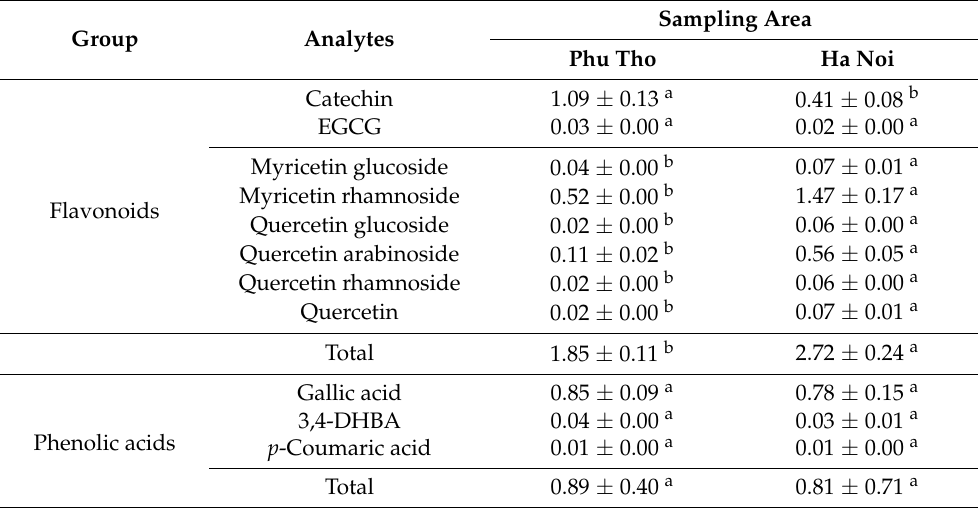
Table 3. Phenolic compound contents (mg/g dry leaf) in Syzygium formosum leaves.